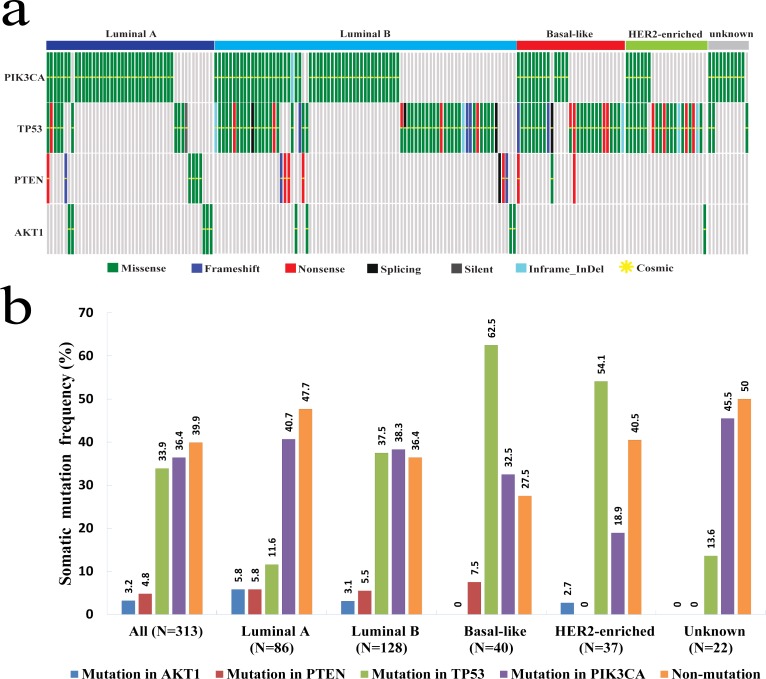
The distribution of somatic mutations in different breast cancer subtypes of the 313 breast cancer patients.a. The graphical summary of somatic mutations of the 4 genes in molecular subtypes. All of the 190 tumor samples with 4 gene somatic mutations are grouped into 5 groups: luminal A (n = 46), luminal B (n = 81), basal-like (n = 29), HER2-enriched (n = 22) and unknown (n = 11). The stripe panel shows every specific case harboring the 4 gene mutation with different mutation types. One stripe indicates one patient. Green stripe indicates missense mutation; Blue stripe indicates frameshift mutation; Red stripe indicates nonsense mutation; Black stripe indicates split site mutation; Dark Gray stripe indicates silent mutation; Cyan stripe indicates inframe indel mutation; Yellow star indicates mutation recorded in COSMIC database. b. The somatic mutation frequency of AKT1, PTEN, PIK3CA and TP53 in different breast cancer subtypes. The frequency of somatic mutations for individual gene is shown in the bar chart in various groups according to molecular subtypes of breast cancer. These groups include All (N = 313), luminal A (N = 86), luminal B (N = 128), basal-like (N = 40), HER2-enriched (N = 37) and unknown (N = 22).